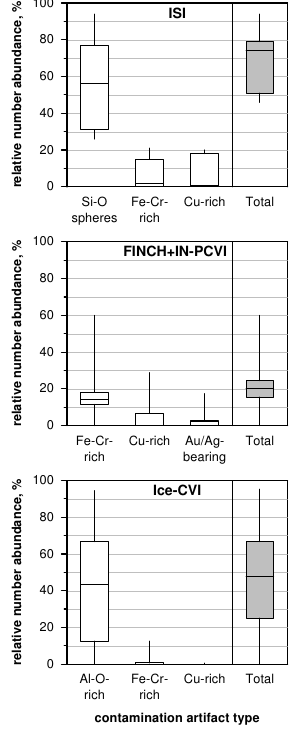
Figure 3. Box plots of the different instrumental contamination ar- tifact particles for each sampling technique. Shown are minimum, lower quartile, median, upper quartile, and